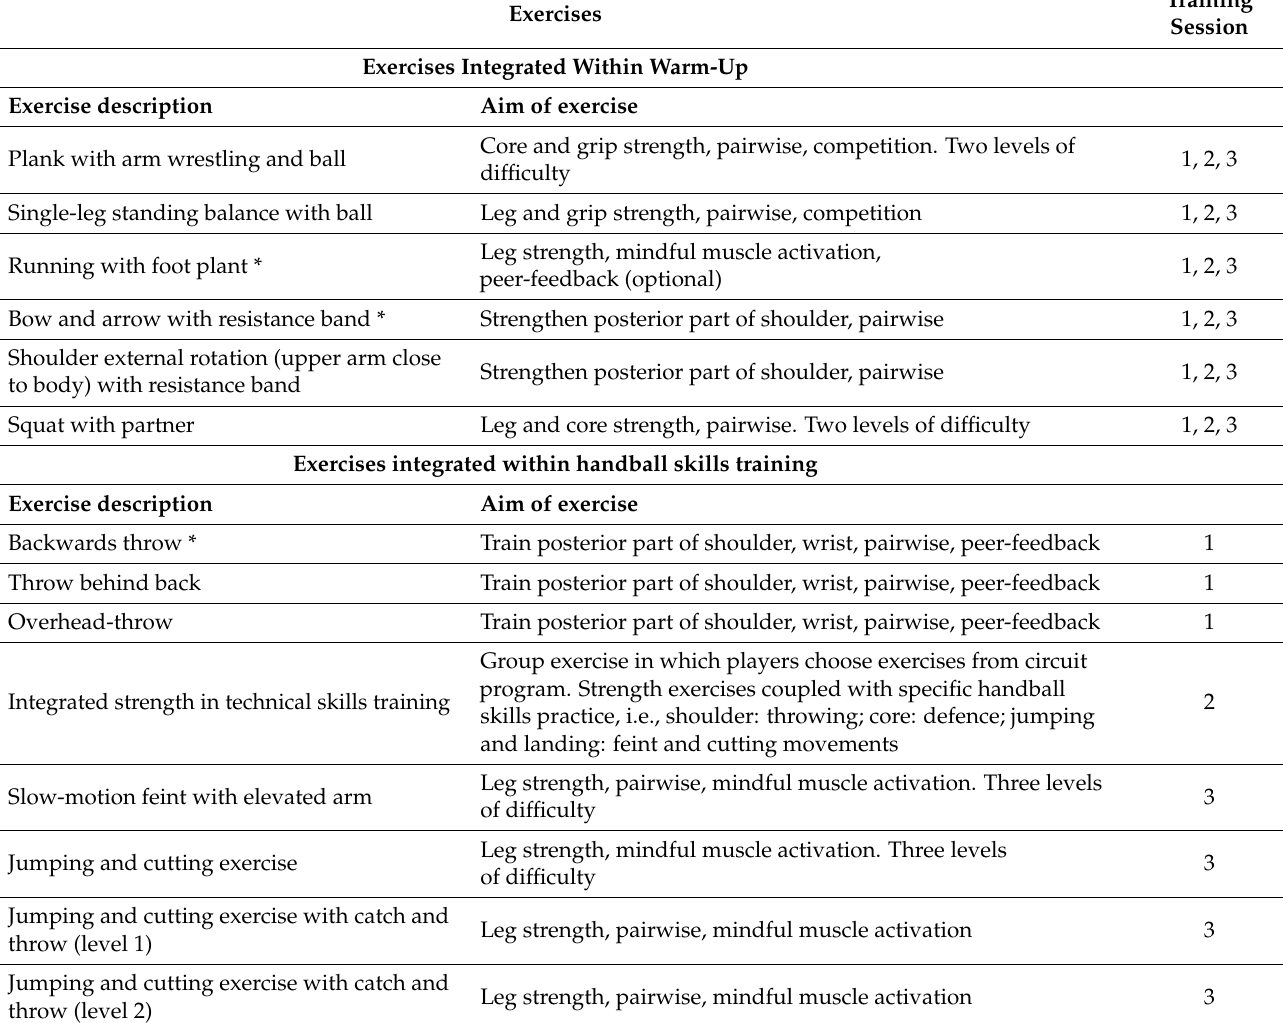
Table 1. Handball-specific injury prevention exercises integrated within warm-up and handball skills training, distributed across three training sessions per week during the 4-week intervention